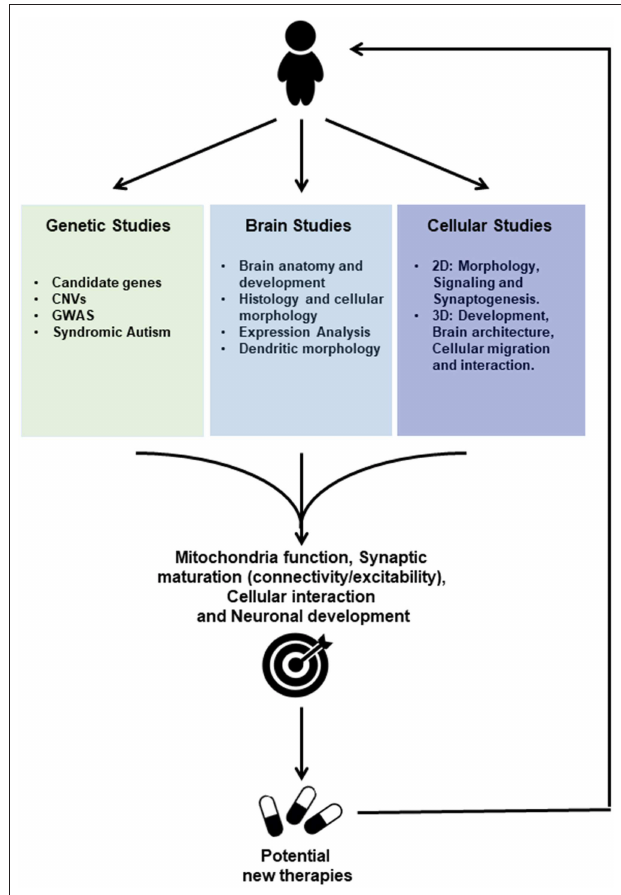
FIGURE 1 | Scheme of ASD Drug discovery based on Genetic Studies, Post-mortem Brain Studies and Cellular Studies using induced pluripotent stem cells (IPSC) for future personalized treatment. Genetic studies reveal associations to Autism Spectrum Disorders either through candidate genes approach or Genome-wide Association Studies (GWAS), whereas genes mutated in syndromic autism have been identified. Furthermore, copy number variations (CNVs) that potentially lead to either gene disruption or duplication were more recently identified. Studies performed on post-mortem tissue provide information about brain anatomy and development, histology and cellular morphology, besides gene and protein expression profiles. Cellular Studies based on IPSC technology may be employed to generate neurons and other cell types (2D) and brain organoids (3D) using cells from patients. Those IPSC-derived models where used to investigate gene expression profiles and cellular morphology as well as cell signaling, synaptogenesis and electrophysiological properties. Moreover, 3D Studies allow to further investigate cellular migration and interaction during development. Those studies provide convergent information regarding the pathophysiology of the Autism Spectrum Disorders, toward altered mechanisms related to Mitochondria function, Synaptic maturation, Cellular interactions, and neuronal development. IPSC-derived cells are currently used to further investigate those altered functions and constitute human in vitro systems allowing drug screenings for potential targets that could lead to new therapies for ASDs.